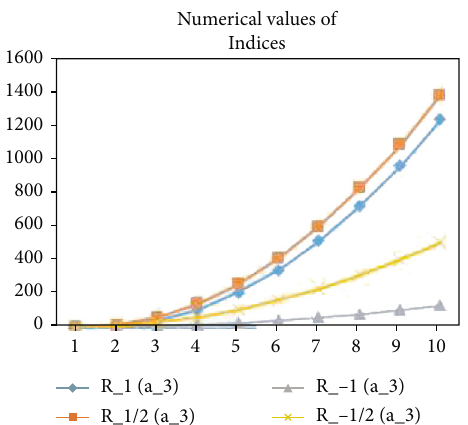
Figure 7: Comparison of indices for THDN4 ð 7 Þ .